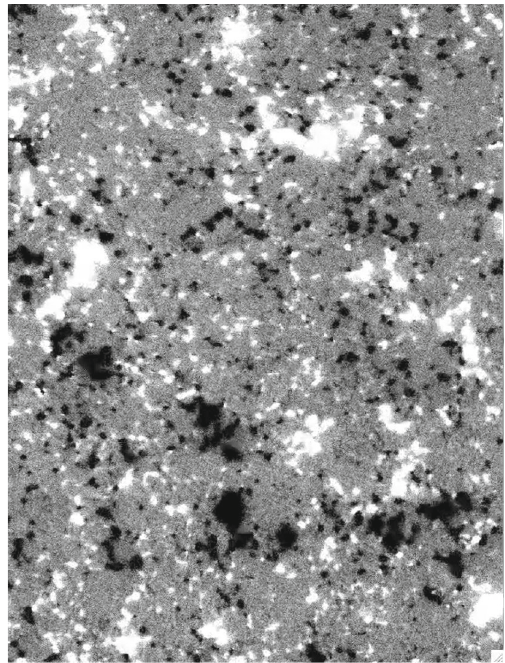
Fig. 11 Still from a movie showing the evolution of a quiet Sun region at the disk center, as observed by the Hinode NFI within the framework of the Hinode Operation Plan 151 ( Flux replacement in the solar network and internetwork ) on 20–21 January 2010. The measurements consists of longitudinal magnetograms obtained in the two wings of Na i 589.6 nm at ± 16 pm from line center. The total exposure time per magnetogram was 6.4 s, resulting in a sensitivity of 6 G. The sequence lasts 20 h and has a cadence of 1 min. There is a gap of about 29 min in the middle. The dimensions of the field of view are 93 (cid:2)(cid:2) × 123 (cid:2)(cid:2) , with a pixel size of 0 . 16 (cid:2)(cid:2) . (For movie see Electronic Supplementary